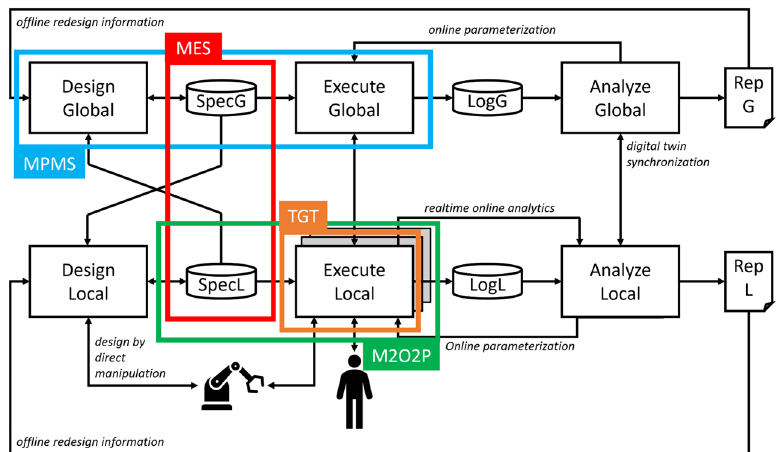
Figure 9. High-level logical architecture with the use case components mapped on it. MPMS oper- ates on global level and shares the specification through MES with local level components. In exe- cution, the MPMS communicates with the local level components TGT and